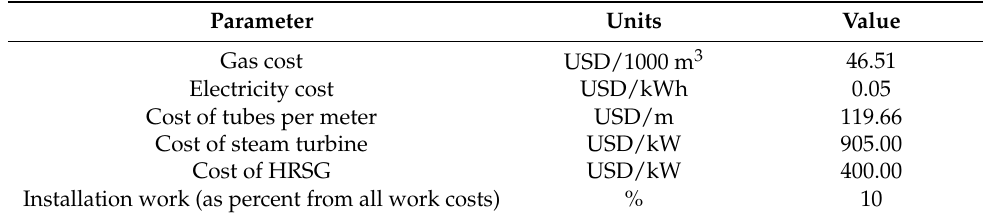
Table 5. Basic data for economic